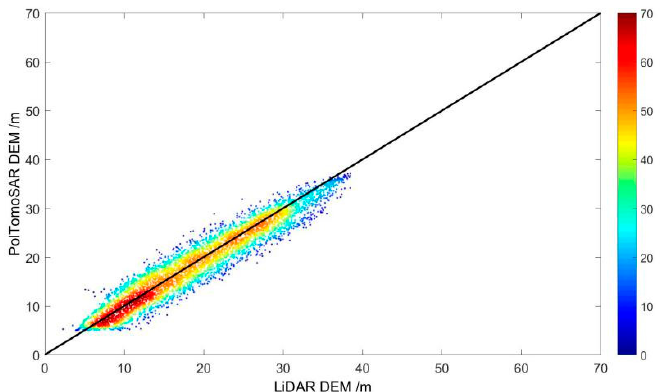
Figure 8. Scatter density plot of LiDAR DTM and PolTomoSAR DTM.